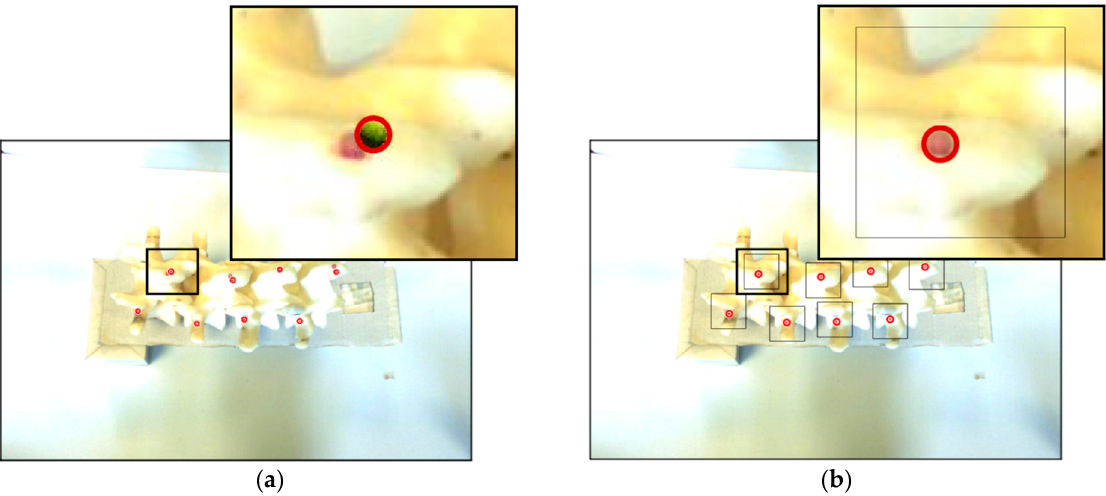
Figure 9. Examples of corresponding images of AR Set and Real Set from the Cam Top view. ( a, left ) Image from the AR Set: the eight detected digital markers are circled in red, and a zoomed view of the first top left marker is provided. ( b, right ) Image from the Real Set: the detected 3D ‐ printed markers are circled in red with each region of interest (ROI) enclosed by a black ‐ edged square, and a zoomed view of the first top left marker is provided.